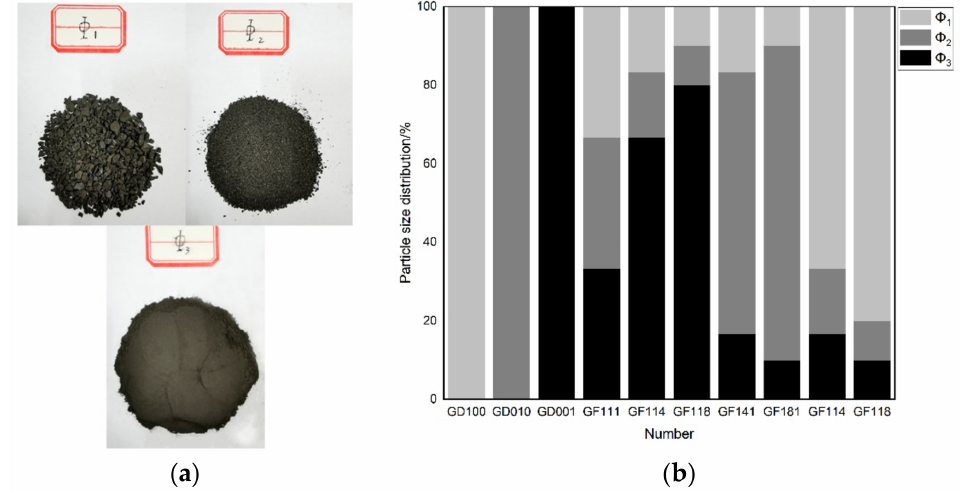
Figure 2. Pictures of tectonic coal particles and grading schemes of samples. ( a ) Tectonic coal particle. ( b ) Grading schemes of tectonic coal